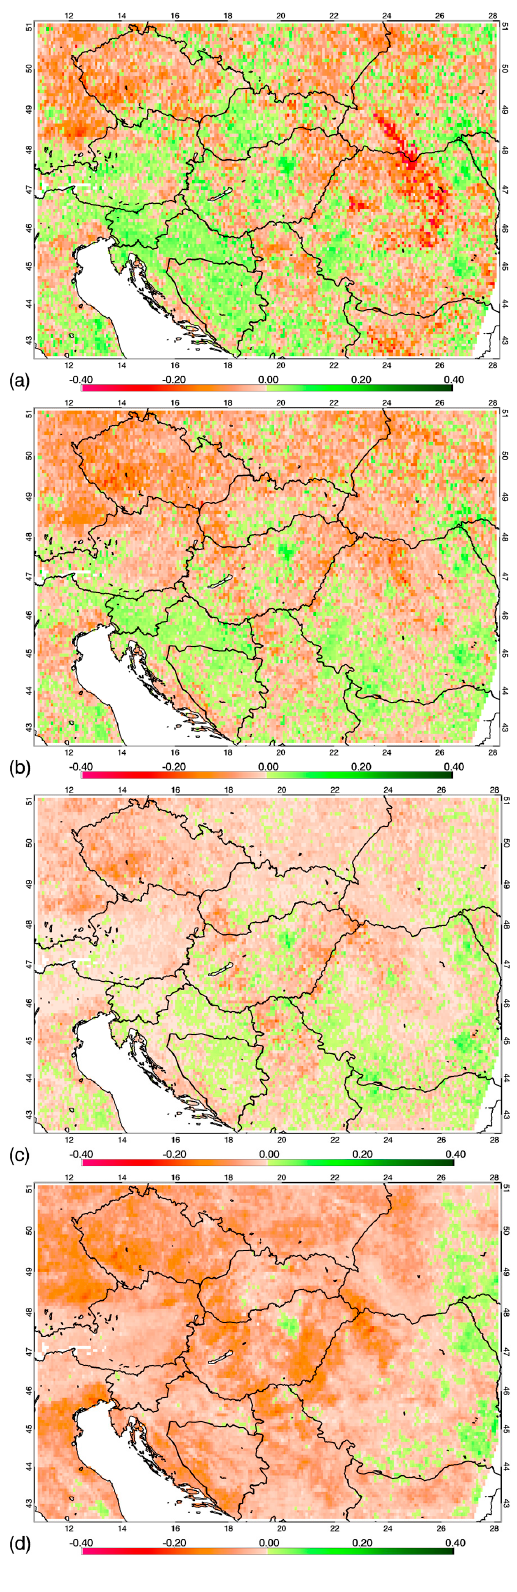
Figure 5. NDVI anomaly maps for the first half of September 2003 after a severe heatwave and exceptional drought in Europe for ( a ) NDVI3g O ; ( b ) NDVI3g F ; ( c ) NDVI3g H and ( d ) (Terra) NDVI MODIS , where the anomaly was referring to the period of 2000-2013.